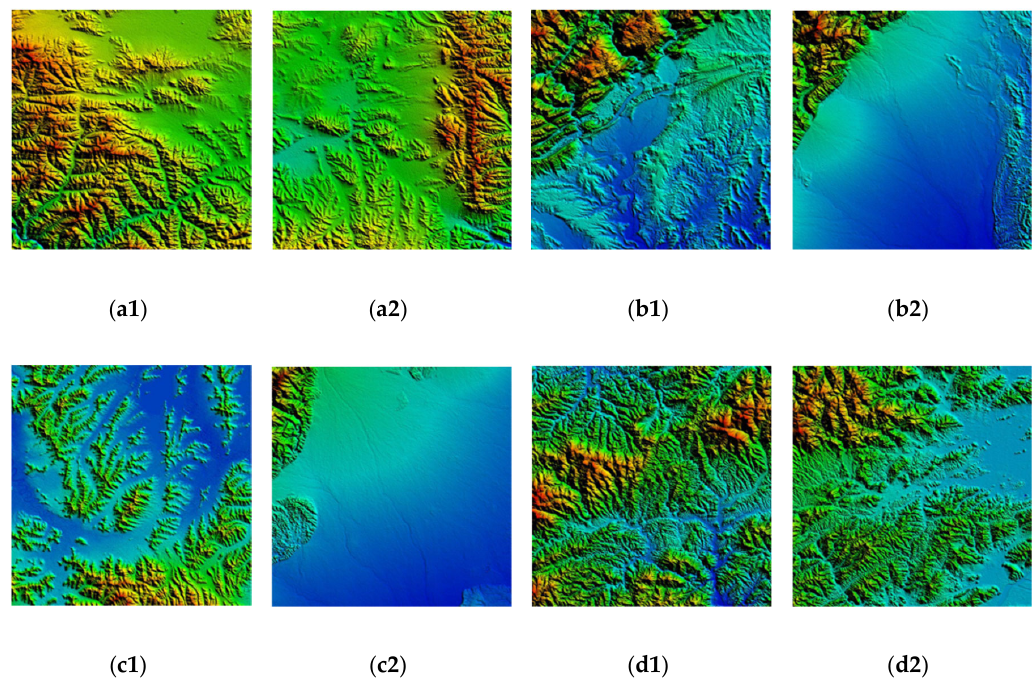
Figure 6. Eight digital elevation models, paired by letter, taken from the experimental data of Gao et al. [18]. Table 2. The absolute Boltzmann entropy and its computation time, as calculated by the traditional method used by Gao et al. [18] and our proposed method.